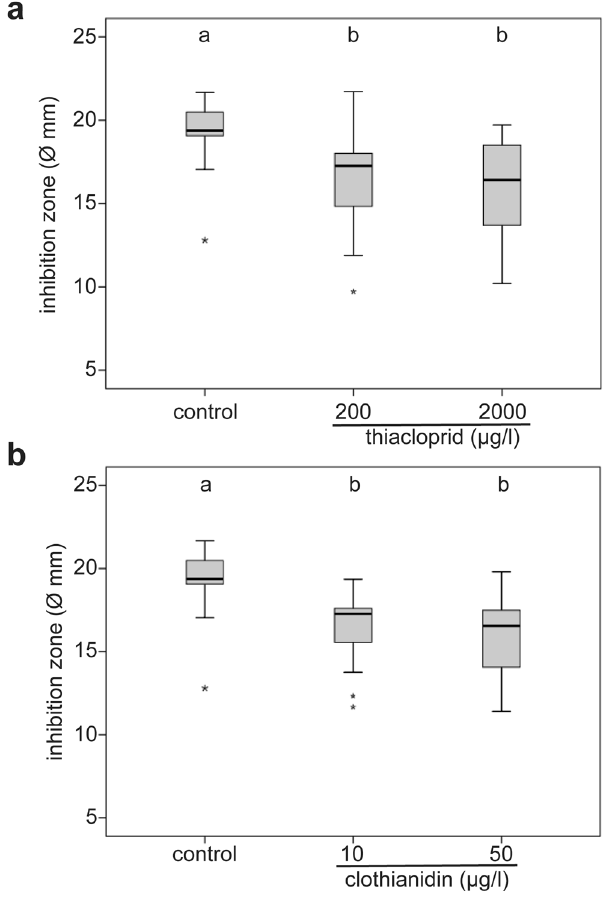
Figure 4. Neonicotinoid exposure reduced antimicrobial activity of hemolymph. The hemolymph inhibited the growth of grampostive bacteria ( Micrococcus flavus ) on agar plates. The seven day-treatment with thiacloprid (( a ), control: n = 15: 200 µ g/l: n = 16; 2000 µ g/l: n = 15) or clothianidin (( b ), control: n = 15: 10 µ g/l: n = 14; 200 µ g/l: n = 14) reduced the antimicrobial activity of the hemolymph, the diameter of the inhibition zones being smaller than in control queens. Boxes show 1st and 3rd interquartile range with black lines denoting medians. Whiskers encompass 95% of the individuals, beyond which outliers reside (asterisks). Significant differences indicated with